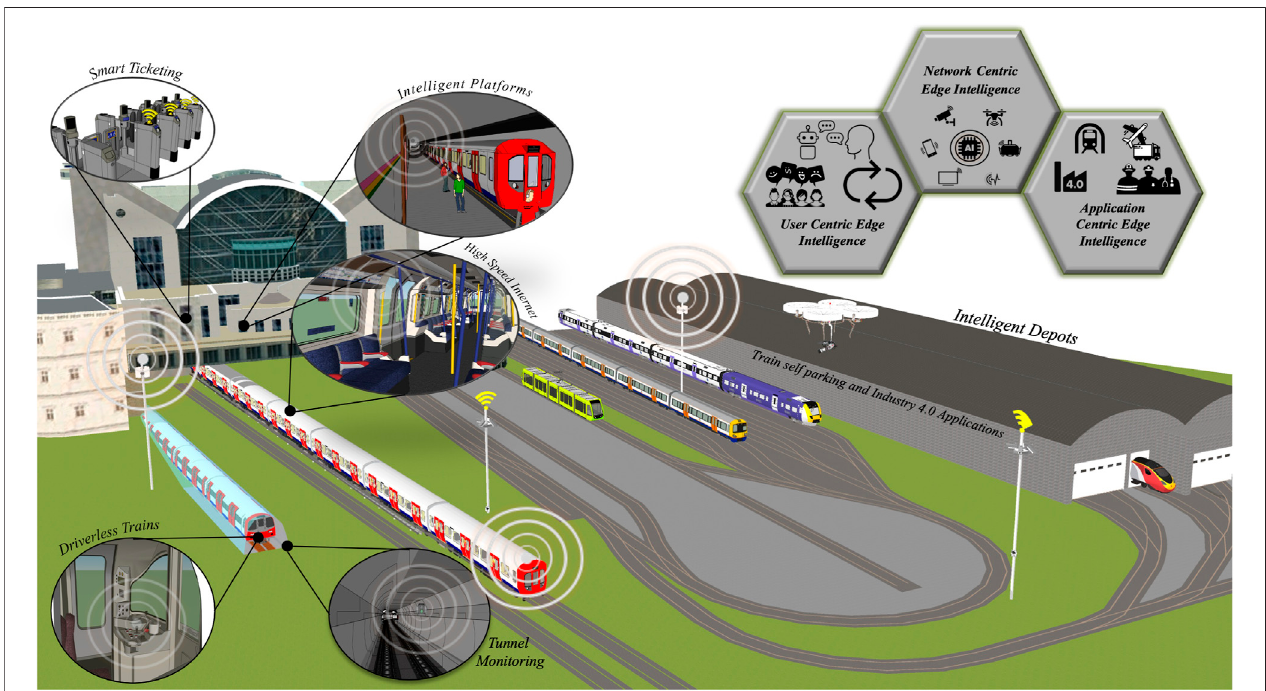
FIGURE 1 | Intelligent Private Network (IPN) with user, network, and application-centric edge intelligence for Next-Generation Railway Systems (NGRSs).